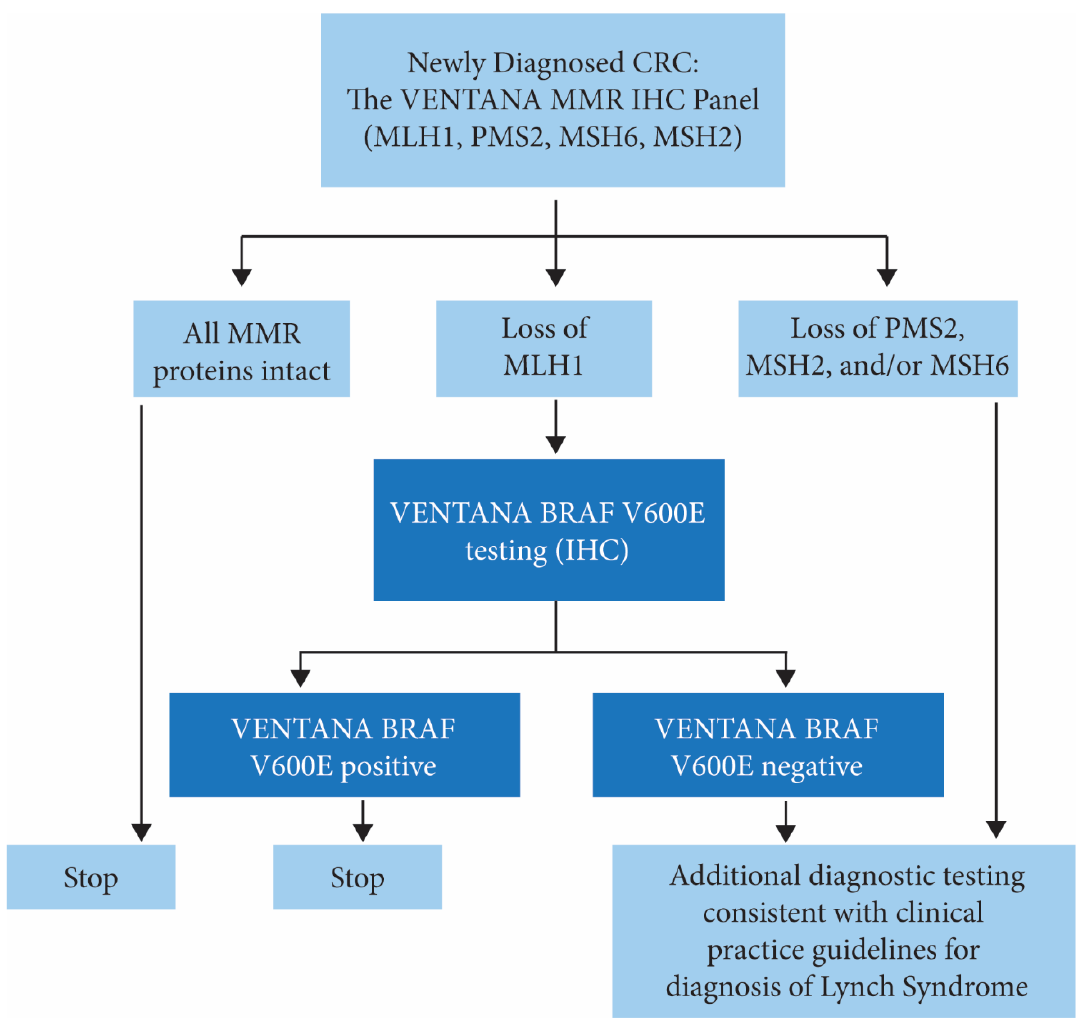
Figure 4. Proposed MMR testing algorithm for the identification of individuals at risk for Lynch syndrome in patients diagnosed with CRC. Additional testing of samples with MLH1/PMS2 loss and negative BRAF V600E could include MLH1 promoter hypermethylation testing and/or referral to medical genetics and/or genetic counseling for germline MMR gene testing.